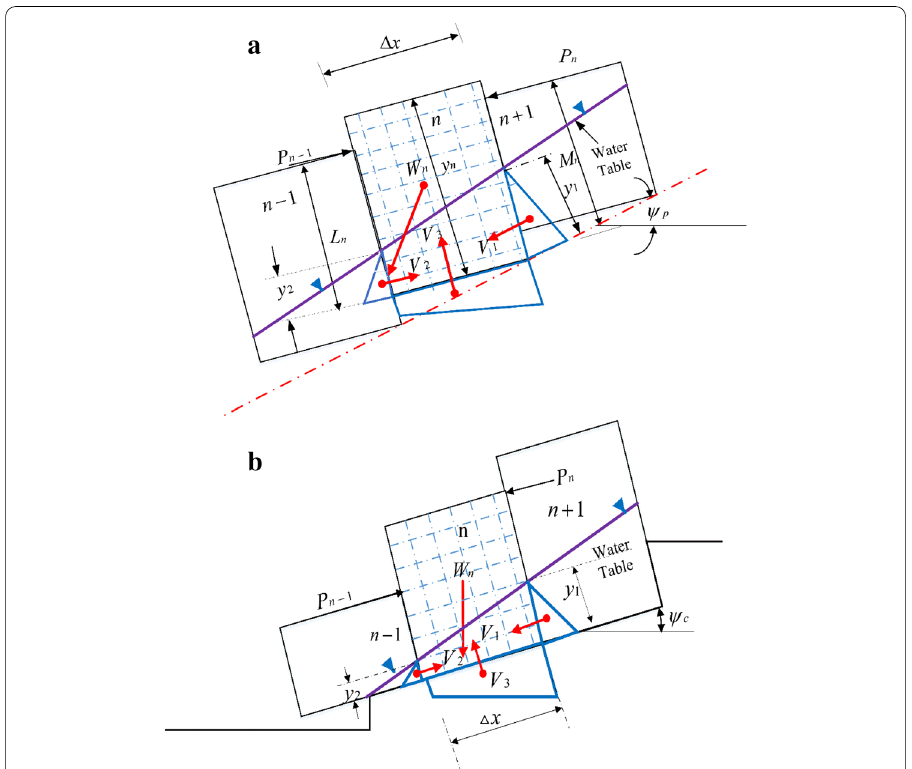
Fig. 5 slide-head-toppling mechanism with external forces: a Forces acting on a typical nth block above crest b Forces acting on a typical nth block below